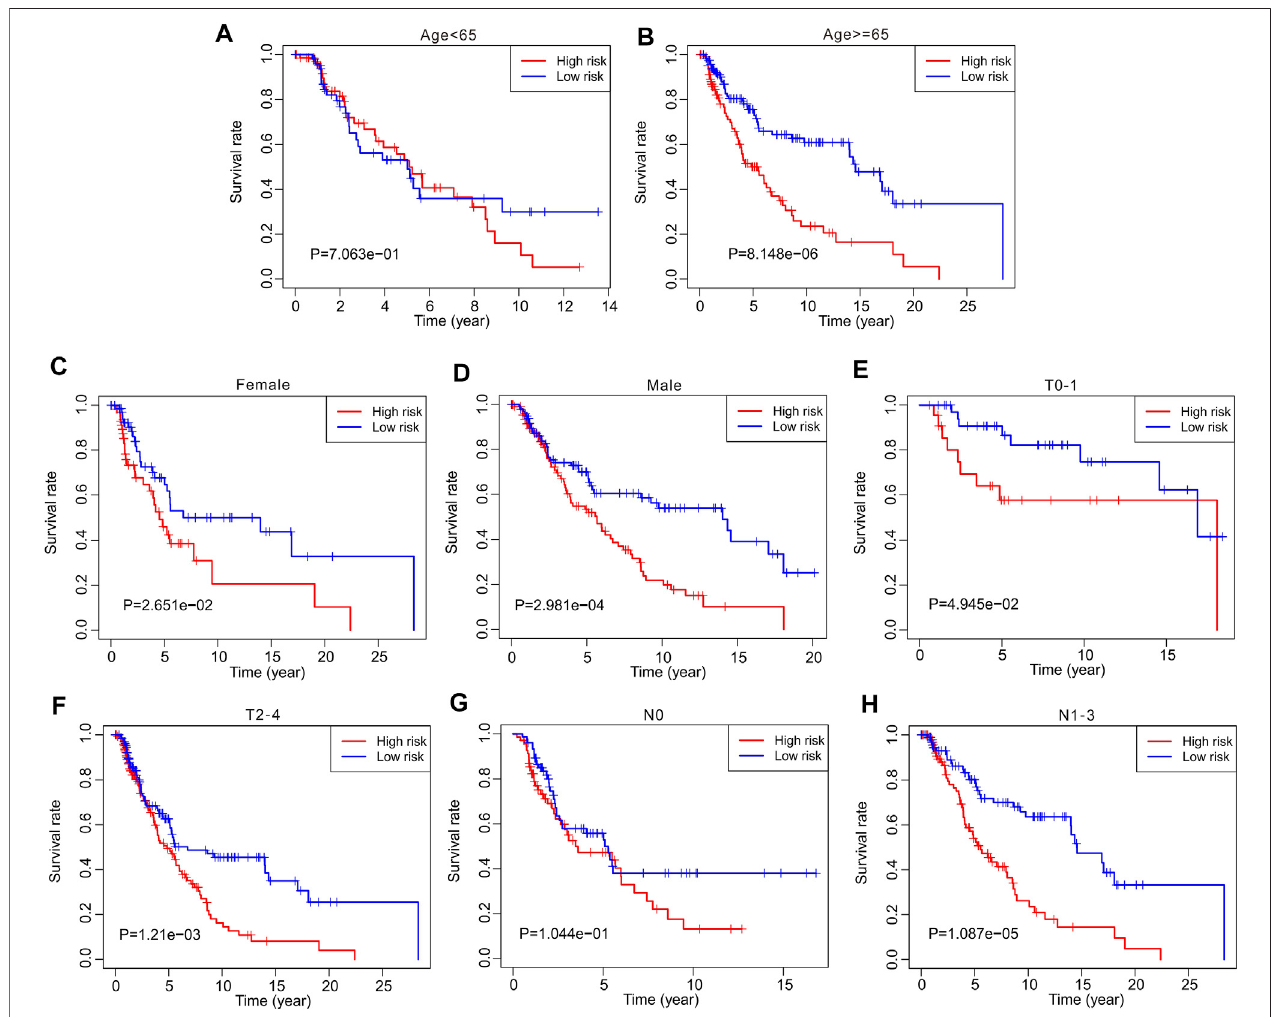
FIGURE 5 | The Kaplan-Meier survival curve analysis of clinicopathological characteristics. The Kaplan-Meier survival curve analysis shows the overall survival rate of low- and high-risk in CM patients strati fi ed by (A,B) Age < 65 vs. ≥ 65, (C,D) Female vs. Male, (E,F) T 0 – 1 vs. T 2 – 4, (G,H) N 0 vs. N 1 – 3.